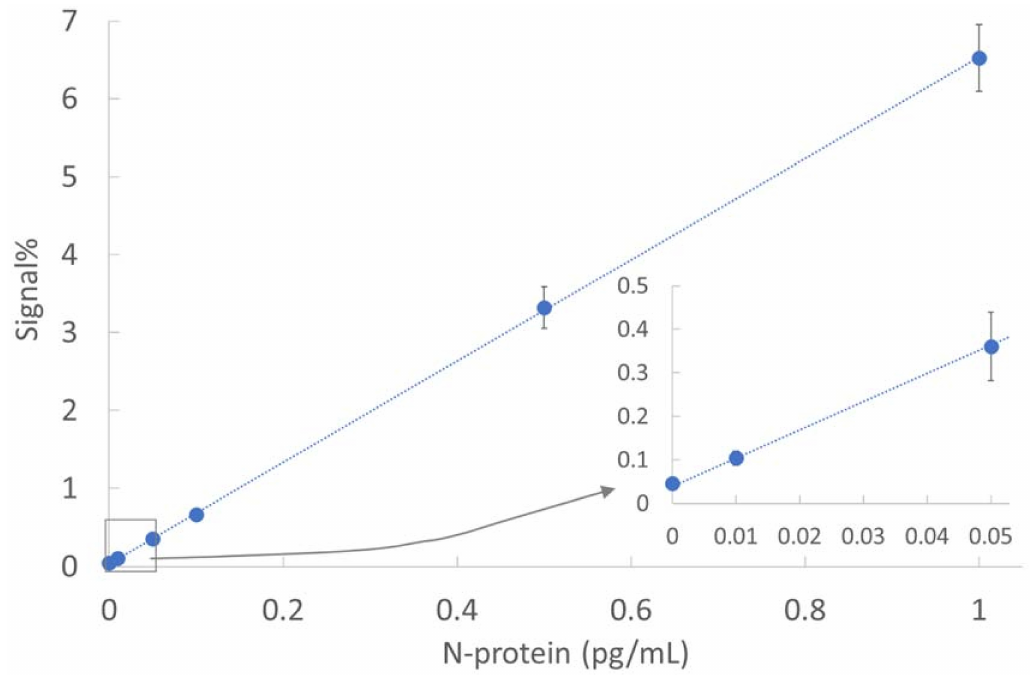
Figure 3. Dose response with recombinant SARS-CoV-2 nucleocapsid